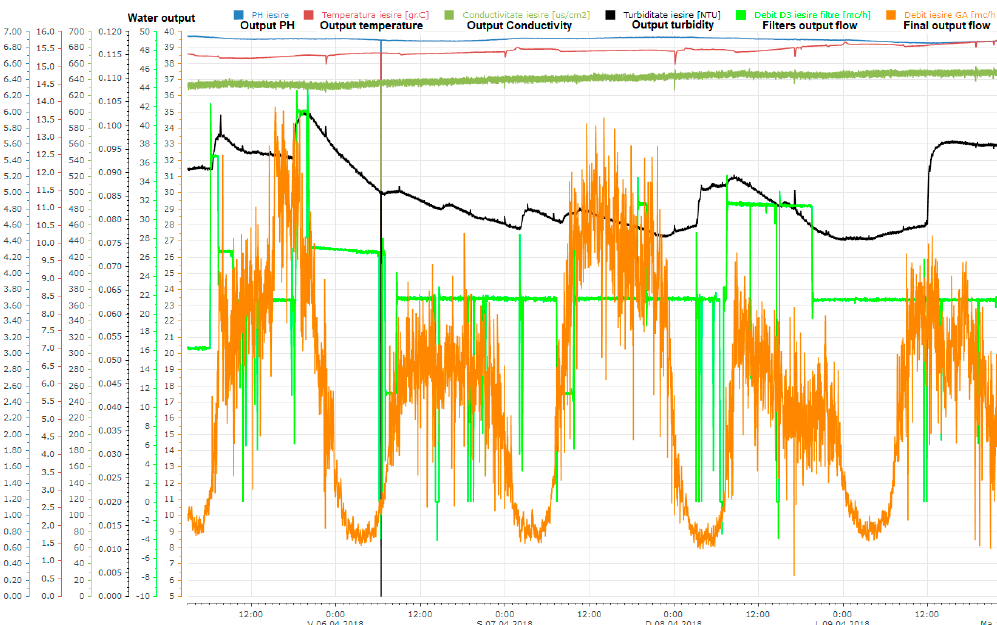
Figure 12. Treatment/distribution output parameters.